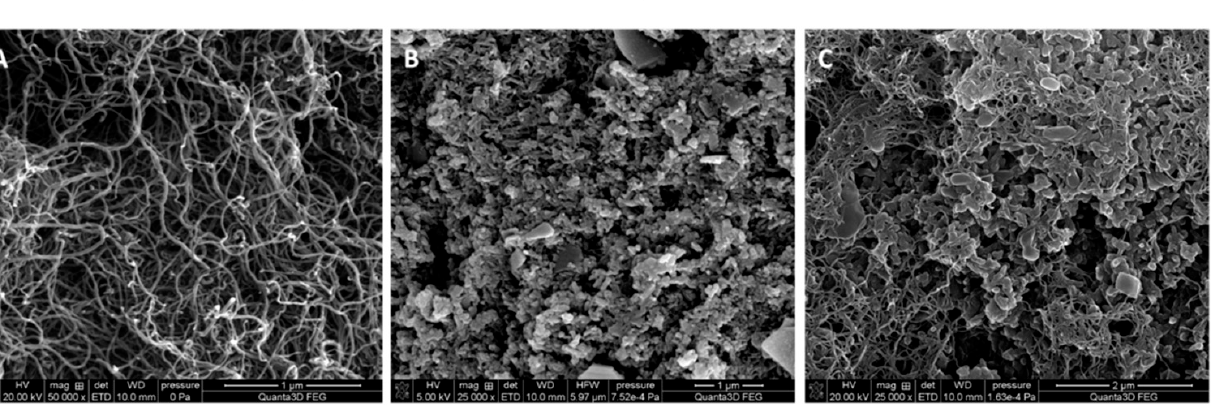
Figure 1. SEM images obtained for the layers of ( A ) MWCNTs, ( B ) PANINFs-Cl, ( C ) (2:1)PANINFs- Cl:MWCNTs nanocomposite.